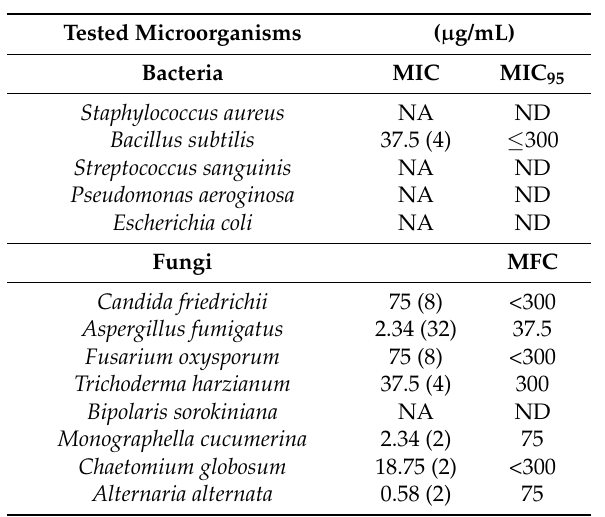
Table 3. Antimicrobial inhibitory effect of muscotoxin A ( 2 ) against Gram-positive and Gram-negative bacteria and plant pathogenic